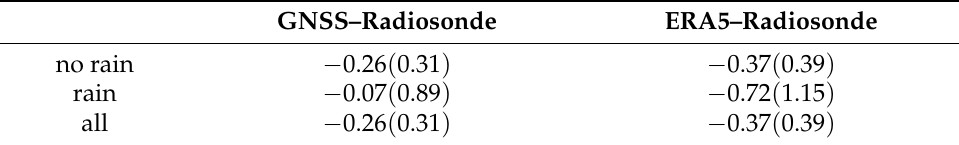
Table 2. Mean differences of IWV (mm) and root mean square errors (RMSE) of GNSS and ERA5 with respect to the radiosonde. The deviations are listed for the different atmospheric states at Payerne using the monthly means of Figure 2. Rain periods are indicated by precipitation rates > 0.1 mm/10